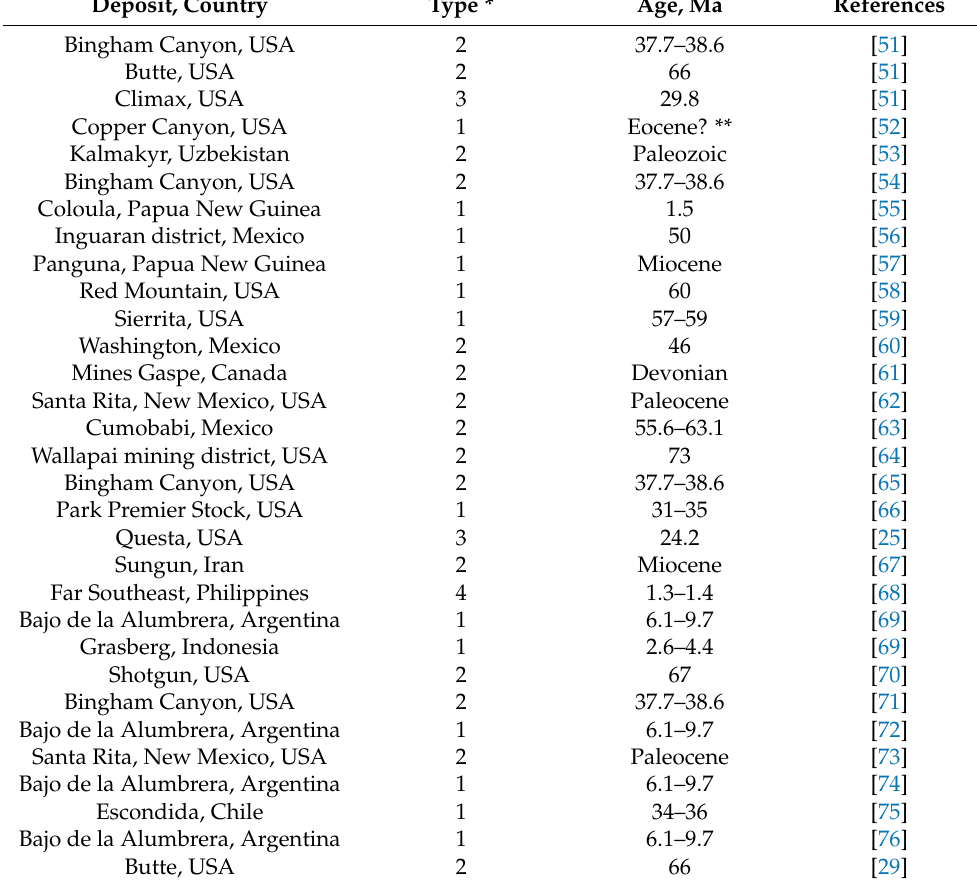
Table 1. Characteristics of porphyry deposits of different geochemical type. Deposit,